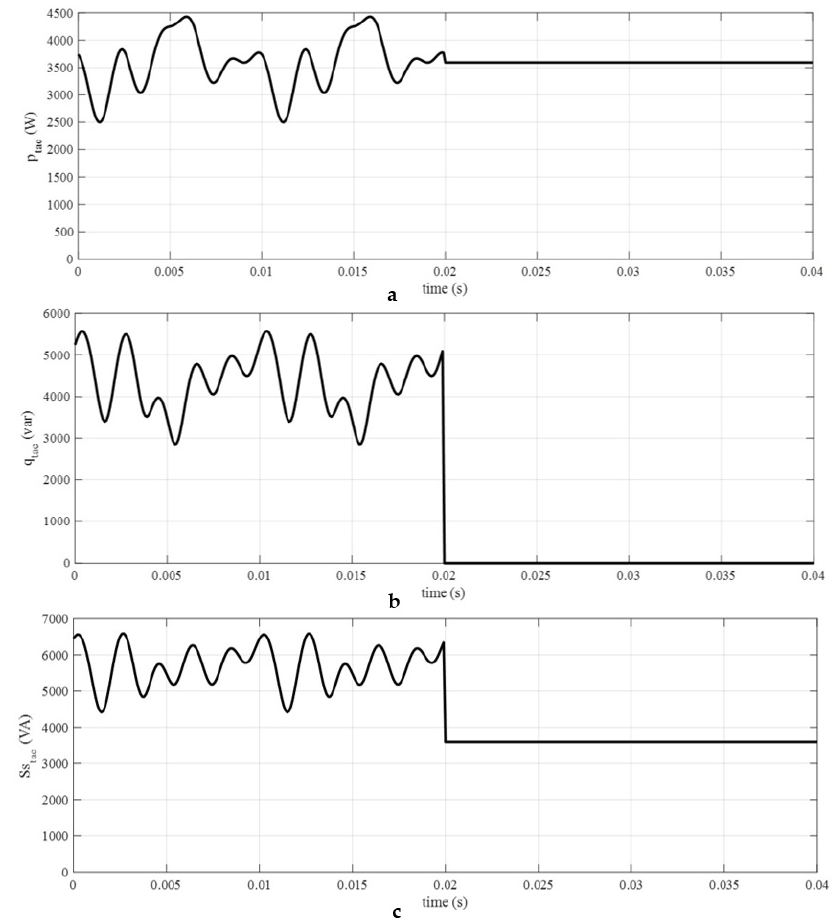
Figure 7. Power variables before/after TAC (t = 0.02 s): ( a ) instantaneous power, ( b ) instantaneous reactive power, ( c ) norm of instantaneous power multivector.